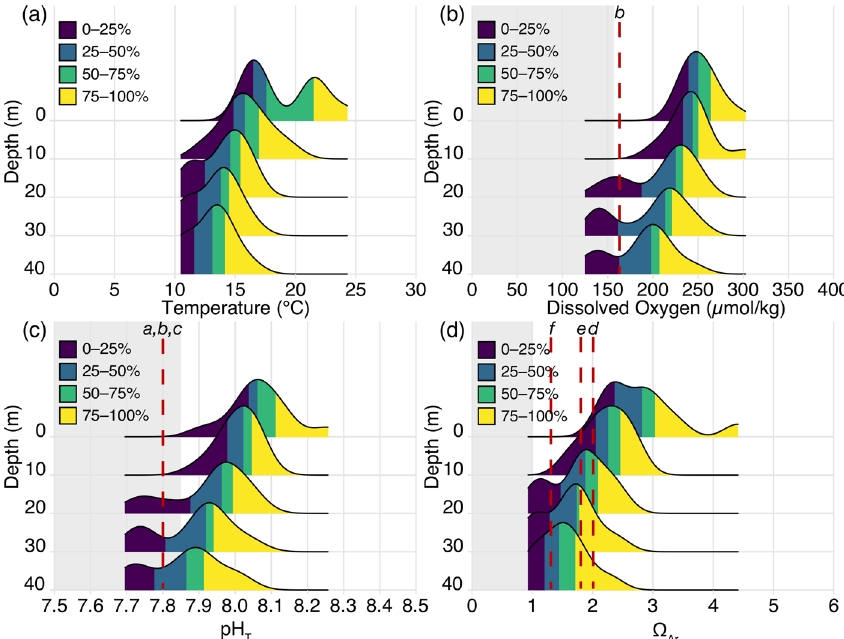
Figure 4. Density ridgeline plots showing frequency distribution of observations of seawater temperature ( a ), DO ( b ), pH T ( c ), and Ω Ar ( d ) at the 0, 10, 20, 30, and 40 m depth bins at Station 4 over the first year of the study. Percentages of observations are displayed in quartiles. Grey regions on panels b , c , and d signify sublethal hypoxic threshold (DO < 157 µmol kg −1 ), mid-century mean oceanic pH T = 7.85 for SSP-5-8.5, and Ω Ar < 1, respectively. Red-dashed lines indicate experimentally observed sensitivity levels for regional fauna as described in Fig. 3 ( a : Olympia oyster 52 , b : market squid 43 , c : purple sea urchin 53–55 , d : Pacific oyster 58 , e : California mussel larvae 57 , and f : pteropods 56